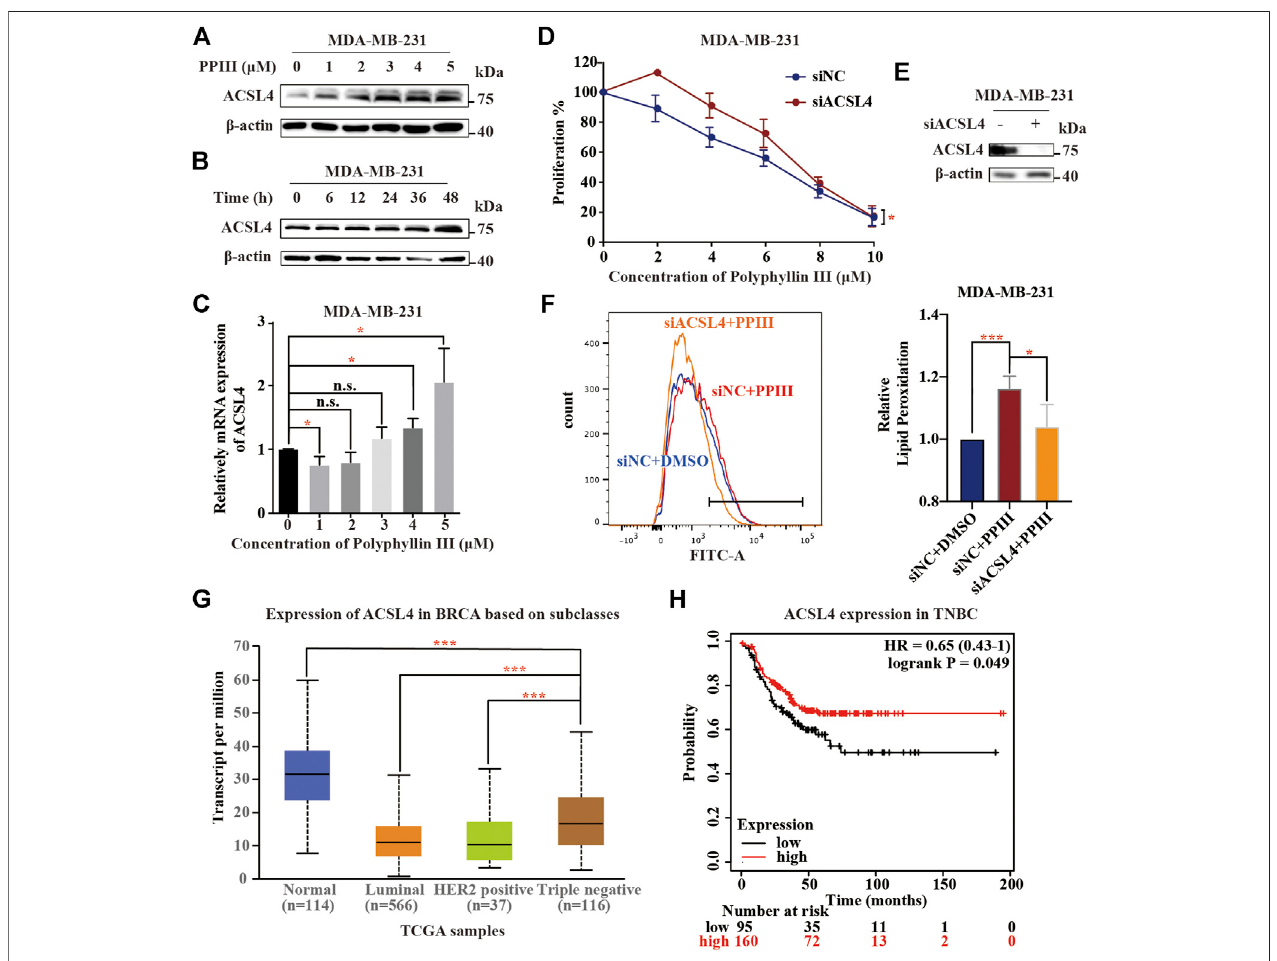
FIGURE 2| Polyphyllin III induces ferroptosis partly by upregulating ACSL4. (A) . Western blot analysis of ACSL4 expression in MDA-MB-231 cells after Polyphyllin III (0 – 5 μ M) treatment for 24 h (DMSO was added to replenish to the same volume). (B) . Western blot analysis of ACSL4 expression in MDA-MB-231 cells after 5 μ M Polyphyllin III treatment for 6, 12, 24, 36, and 48 h. (C) . The relative ACSL4 mRNA level was measured by qRT-PCR after MDA-MB-231 cells were treated with Polyphyllin III (0 – 5 μ M) for 24 h (the error bars show the means ± SD, n (cid:2) 3 independent repeats, p values were calculated using two-tailed unpaired Student ’ s t-test). (D) . MDA-MB-231 cells were transfected with negative control siRNA (siNC) or ACSL4 siRNA (siACSL4) and then treated with Polyphyllin III (0 – 25 μ M) for 24 h. The cell viability was assayed ( n (cid:2) 3 independent repeats, p values were calculated using two-tailed paired Student ’ s t-test). (E) . Western blot analysis of ACSL4 expression in MDA-MB-231 cells after transfection with ACSL4 siRNA for 72 h. (F) . MDA-MB-231 cells were transfected with negative control siRNA (siNC) or ACSL4 siRNA (siACSL4) and then treated with 5 μ M Polyphyllin III for 24 h. The relative levels of lipid peroxidation were assayed by C11-BODIPY fl uorescence (the error bars showthemeans ± SD, n (cid:2) 3independentrepeats, p valueswerecalculatedusingatwo-tailedunpairedStudent ’ st-test). (G) .OnlineUALCANanalysisoftheexpression of ACSL4 in BRCA based on subclasses. (H) . Online Kaplan-Meier Plotter analysis (http://kmplot.com/analysis) of triple-negative breast cancer patient outcomes. Differences in relapse-free survival (RFS) were compared in groups strati fi ed by ACSL4 status. * p < 0.05; ** p < 0.01; *** p < 0.001; n. s., not signi fi cant ( p > 0.05).